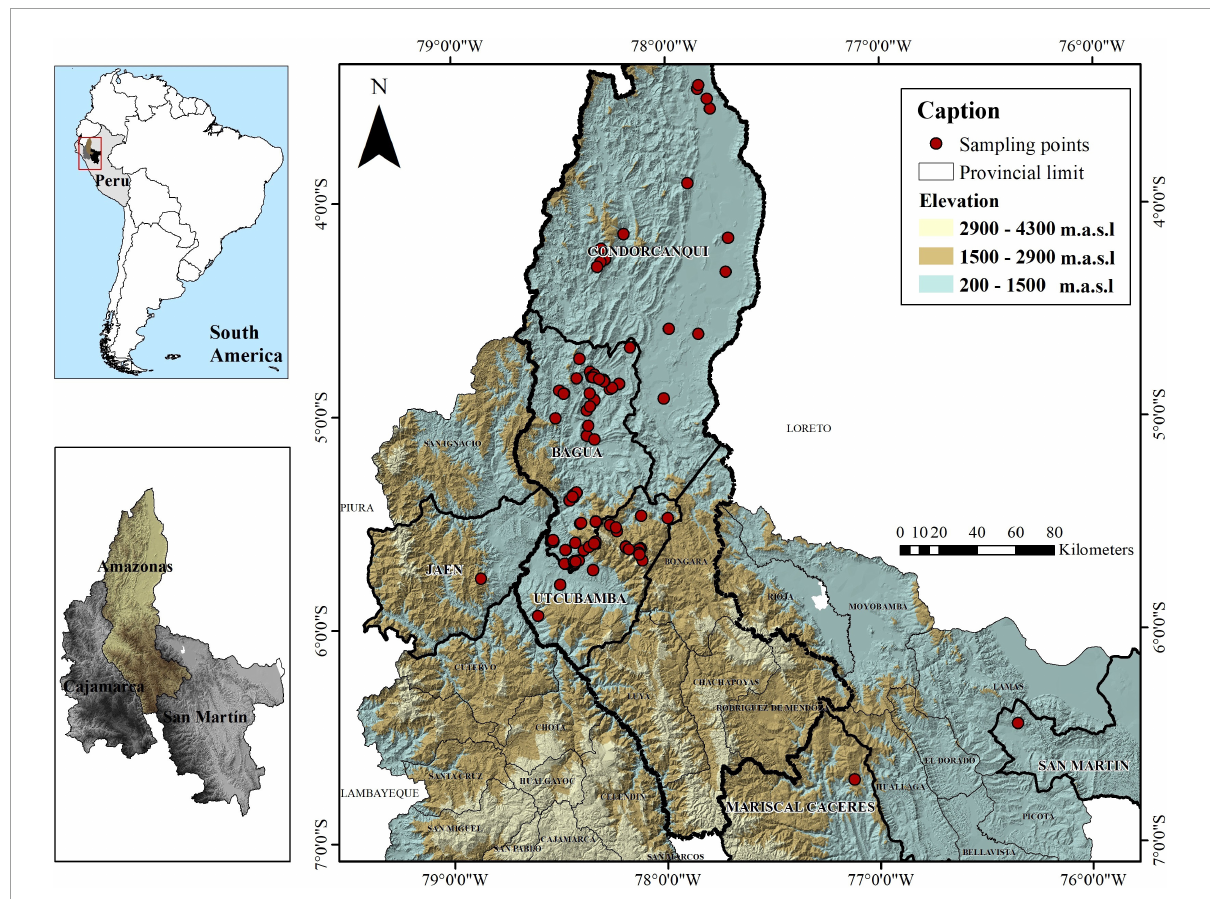
FIGURE1 Distribution of collected Fine Aroma Cacao samples from northern Peru. The national, provincial and district boundaries were obtained from the Geoportal of the National Geographic Institute of Peru (IGN) in shapefile format with a DATUM WGS 1984 for illustrative purposes only.